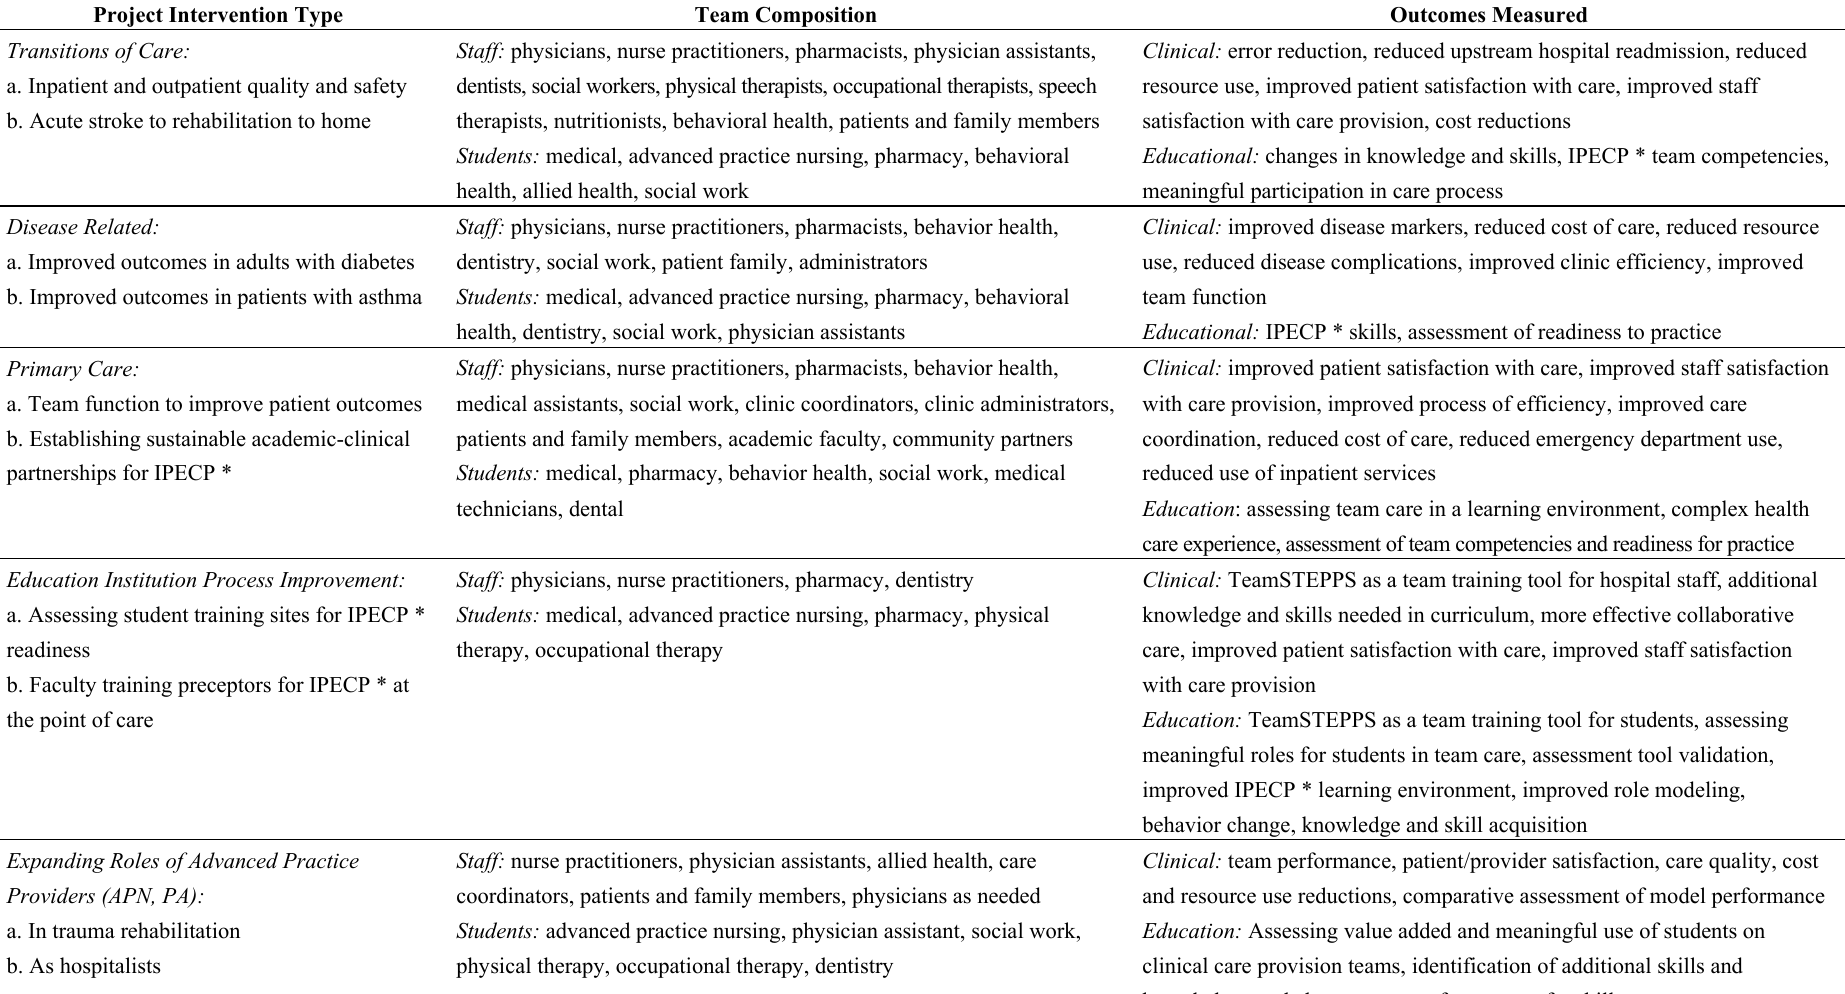
Table 2. Nexus incubator interventions by team composition and measured